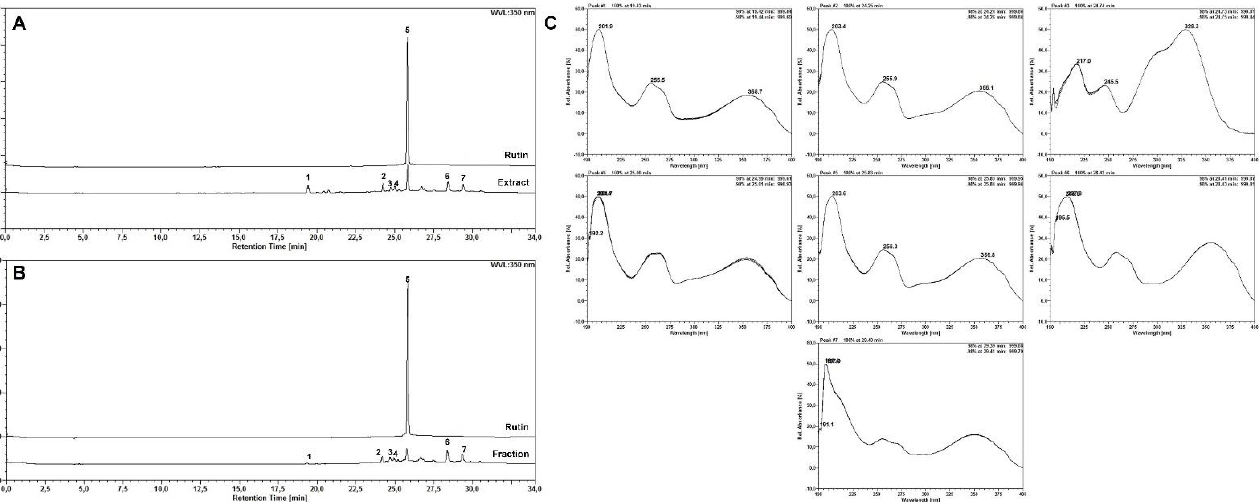
Figure 2. HPLC analysis of Bauhinia monandra samples. Chromatogram of the saline extract ( A ) and fraction ( B ); scan spectra (190 – 400 nm) corresponding to peaks 1 to 7 evidenced in both preparations ( C ). All analyses at 350 nm.